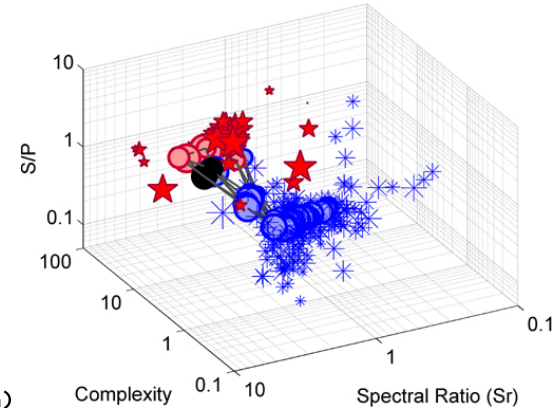
Fig. 5. Red stars indicate earthquakes and blue asterisks represent the quarry blasts; gray lines show the connections between neighboring map units. Red, blue and black circles located at the nodes indicate earthquakes, quarry blast and unlabeled events, respectively, and are classification results from the SOM. (a) Scatter plot of four discrimanants in four dimensions; marker size represents the forth component, time. Large markers indicate late seismic activity. Parts (b) , (c) , (d) are the projections onto the corresponding parameters (axes are log scale).